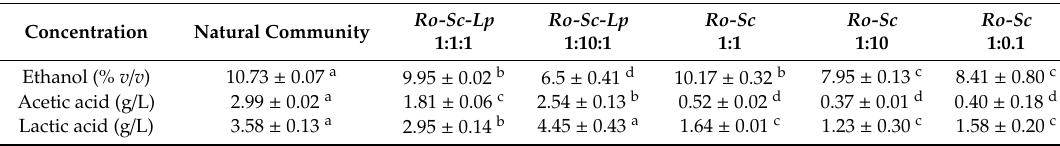
Table 1. Final concentration of ethanol and organic acids at day 10, the end of the traditional rice wine brewing